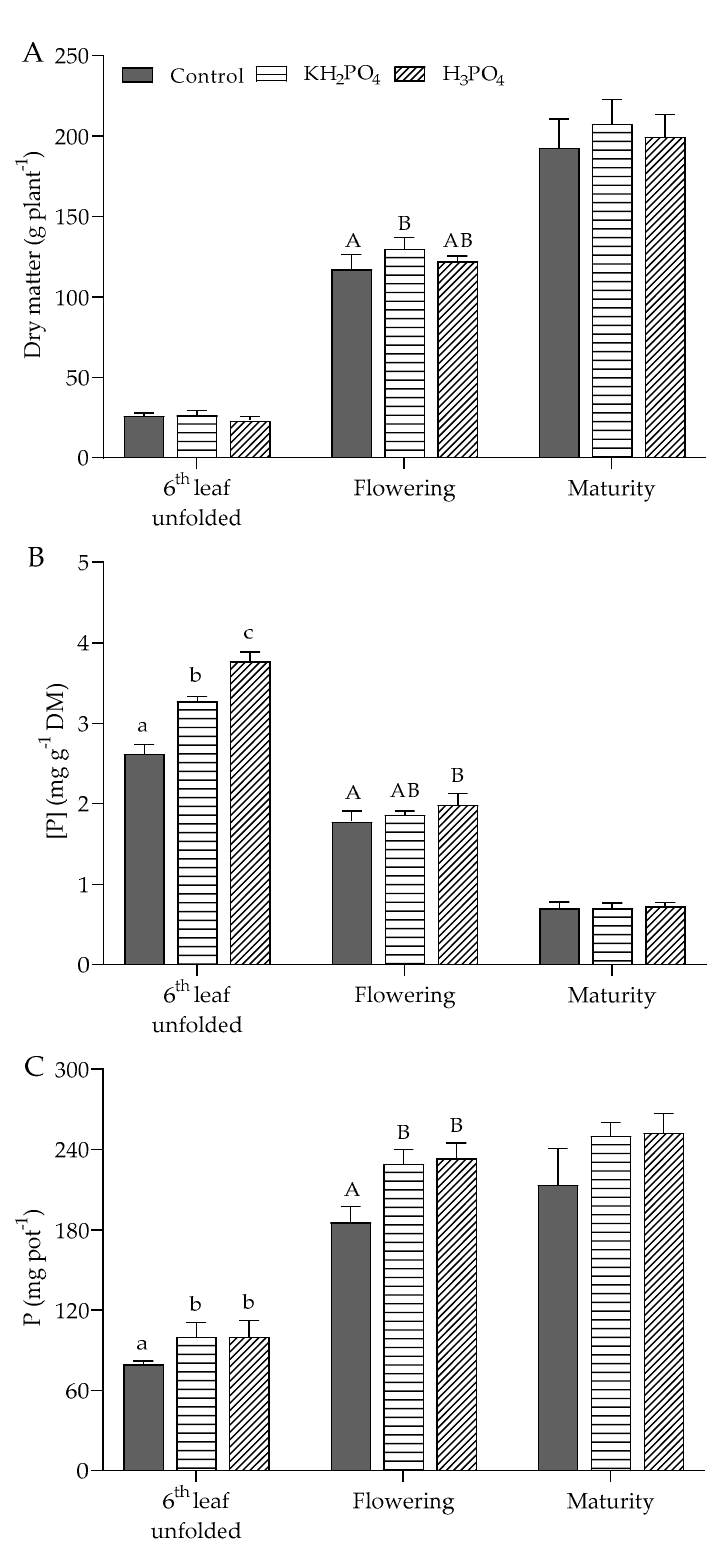
Figure 1. ( A ) Dry matter in g plant − 1 . ( B ) Phosphorus concentration (P) in mg g − 1 dry matter. ( C ) Phosphorus content (P) in mg plant − 1 of the total maize plant. Control without P fertilization (control), three foliar applications of 200 mM potassium dihydrogen phosphate (KH 2 PO 4 ) or phos- phoric acid (H 3 PO 4 ) at 40, 46, and 53 days after sowing. Maize plants were harvested during the 6th leaf stage (BBCH 16), flowering (BBCH 65), or maturity (BBCH 89) over time. Bars represent means + SD ( n = 5). Upper and lower case letters indicate significant differences between treatments within the development stages (ANOVA with Duncan test, p ≤